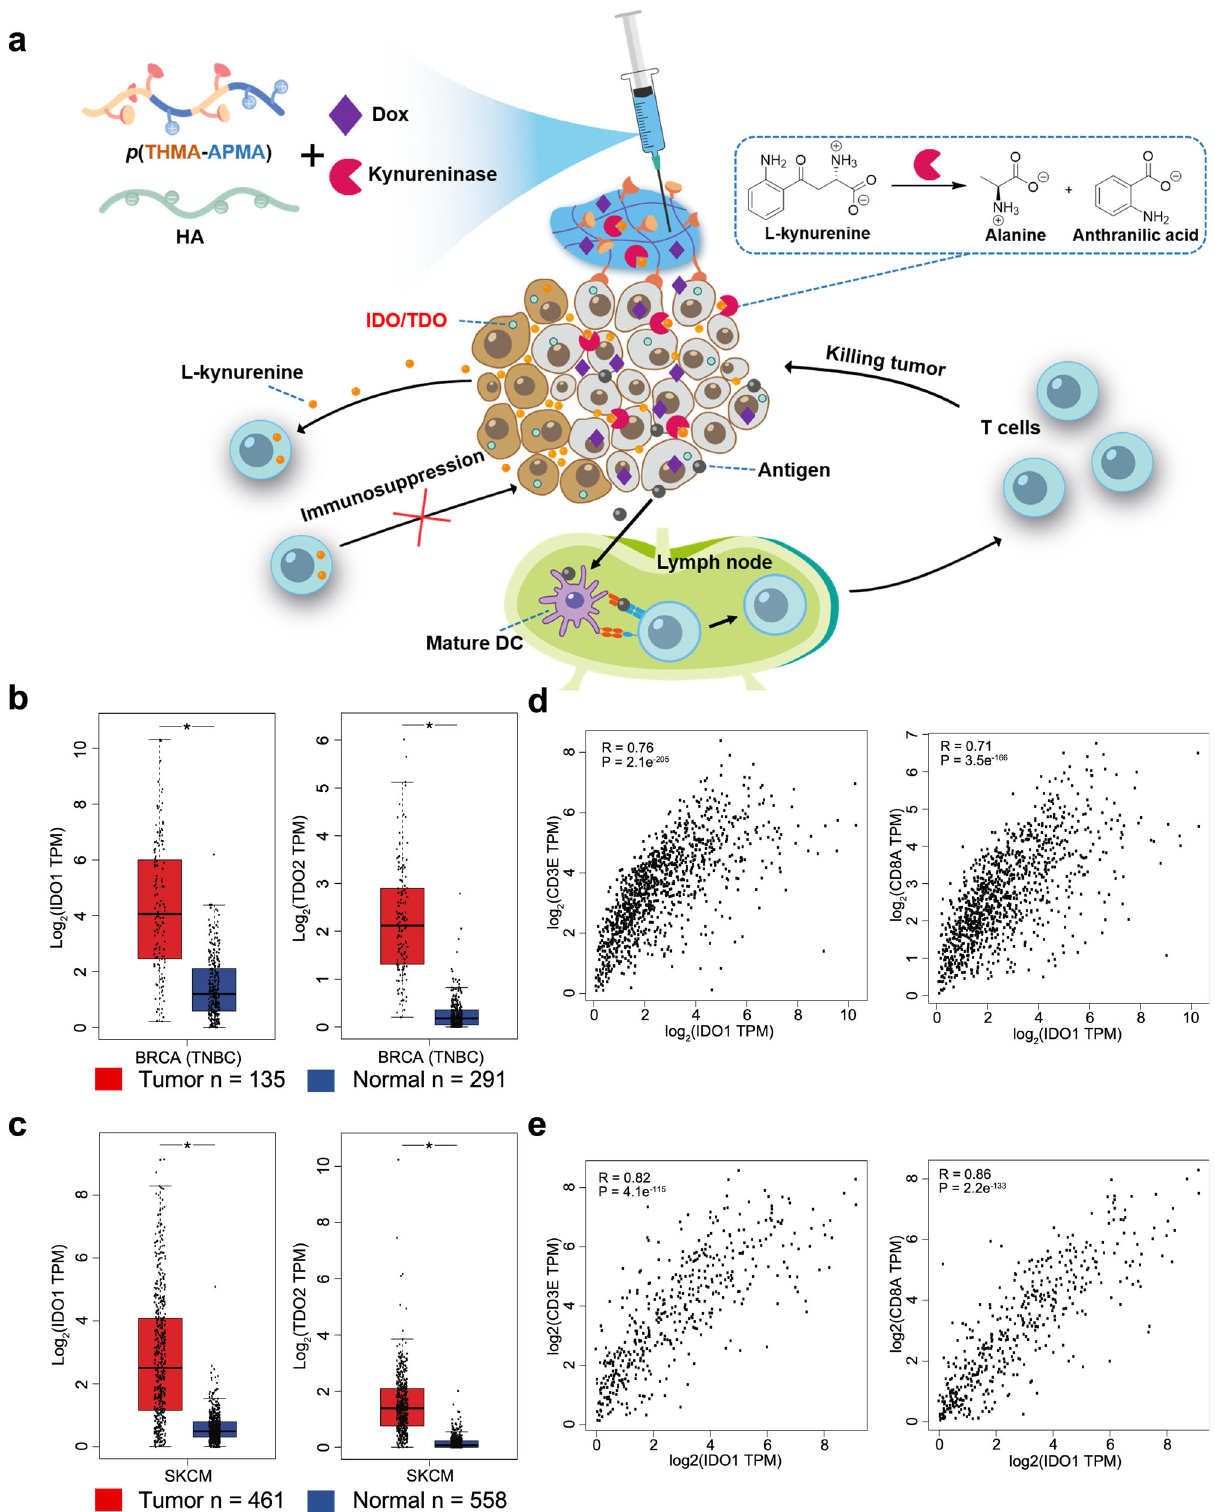
Fig. 1 The elevated levels of IDO1 and TDO2 and their correlations with T cell in fi ltration in human TNBC and melanoma support targeting the key metabolite Kyn for tumor suppression. a Schematics of the localized chemo-immunometabolic therapy enabled by an injectable hydrogel for elicitation of anti-tumor immunity and suppression of tumor growth. b , c Expression of IDO1 and TDO2 in TNBC ( b ) and skin cutaneous melanoma (SKCM) ( c ) or the corresponding normal tissues from the TCGA database, represented as transcripts per million (TPM). Whiskers extend to minimum and maximum values, horizontal bars show the median and boxes encompass 25 th − 75 th percentiles, and statistical signi fi cance was determined by two-tailed t -test. * P < 0.05. d , e Spearman correlation of IDO1 expression with CD3E and CD8A expressions from the TCGA database for TNBC ( d , n = 1085) and SKCM ( e , n =